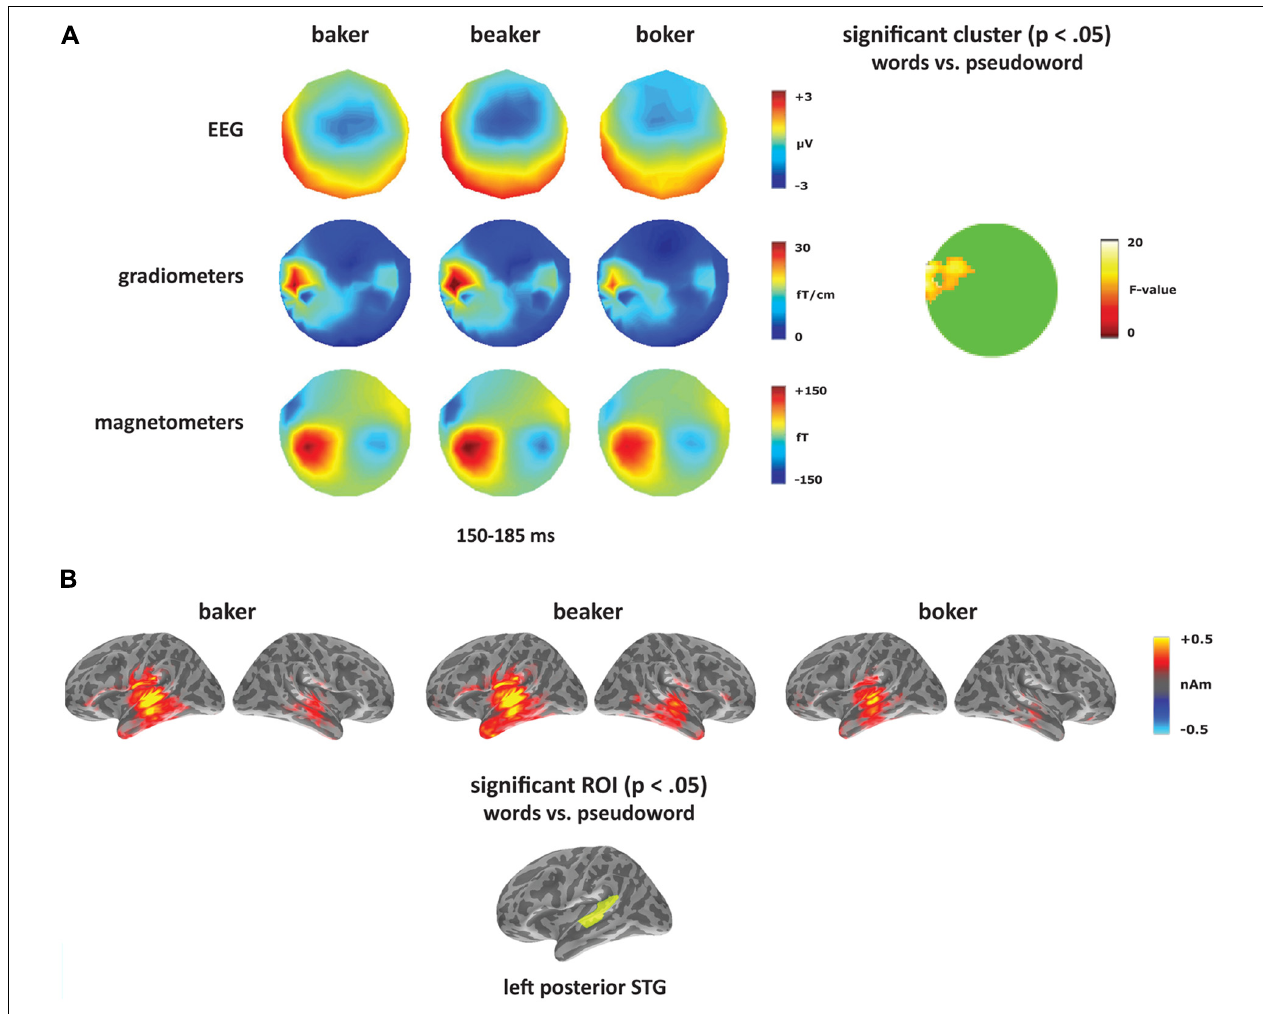
FIGURE 4 |Word–pseudoword contrast: [-er]. (A) Topographies for [-er] deviants ( baker, beaker, boker ) from 150 to 185 ms, and the location of the significant cluster from the sensor analysis. (B) Source activation for [-er] deviants from 150 to 185 ms, and the significant ROI from the source analysis (left posterior STG).